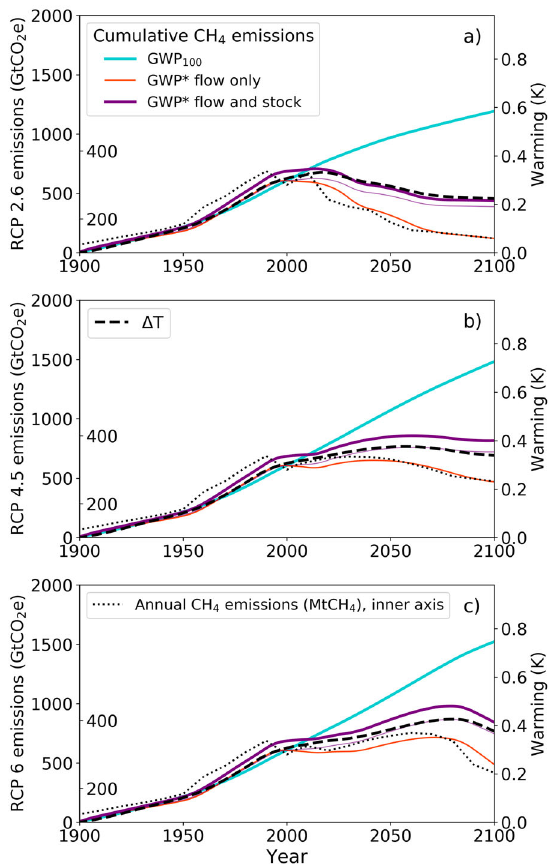
Fig. 2 A reproduction of Fig. 1 from CLA with scaling factor g applied to GWP* (purple solid lines). Cumulative emissions of methane are shown for three scenarios, ( a RCP2.6, b RCP4.5 and c RCP6) aggregated using GWP 100 (cyan), GWP* with s = 0 (orange), GWP* with s = 0.25 and g = 1.13 (purple solid), and GWP* with s = 0.25 and g = 1 (thin purple, largely hidden behind dashed black line in b , c